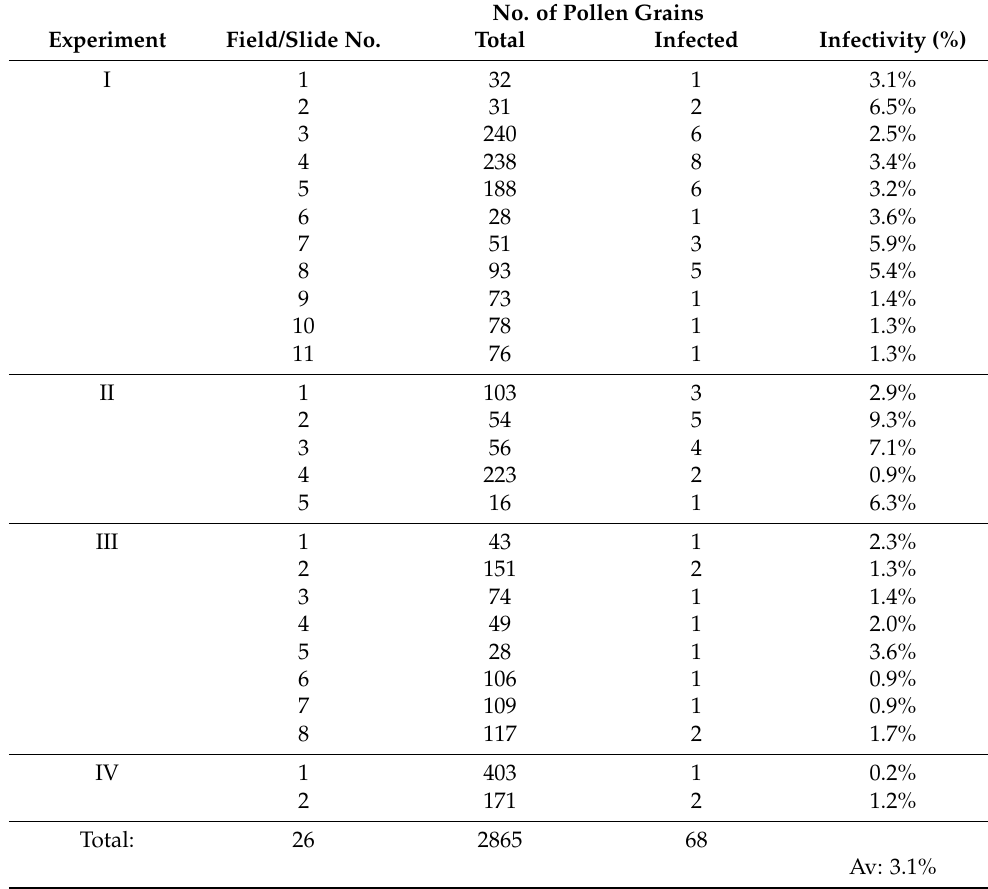
Table 3. Infection of pollen grains harvested from ToBRFV-infected